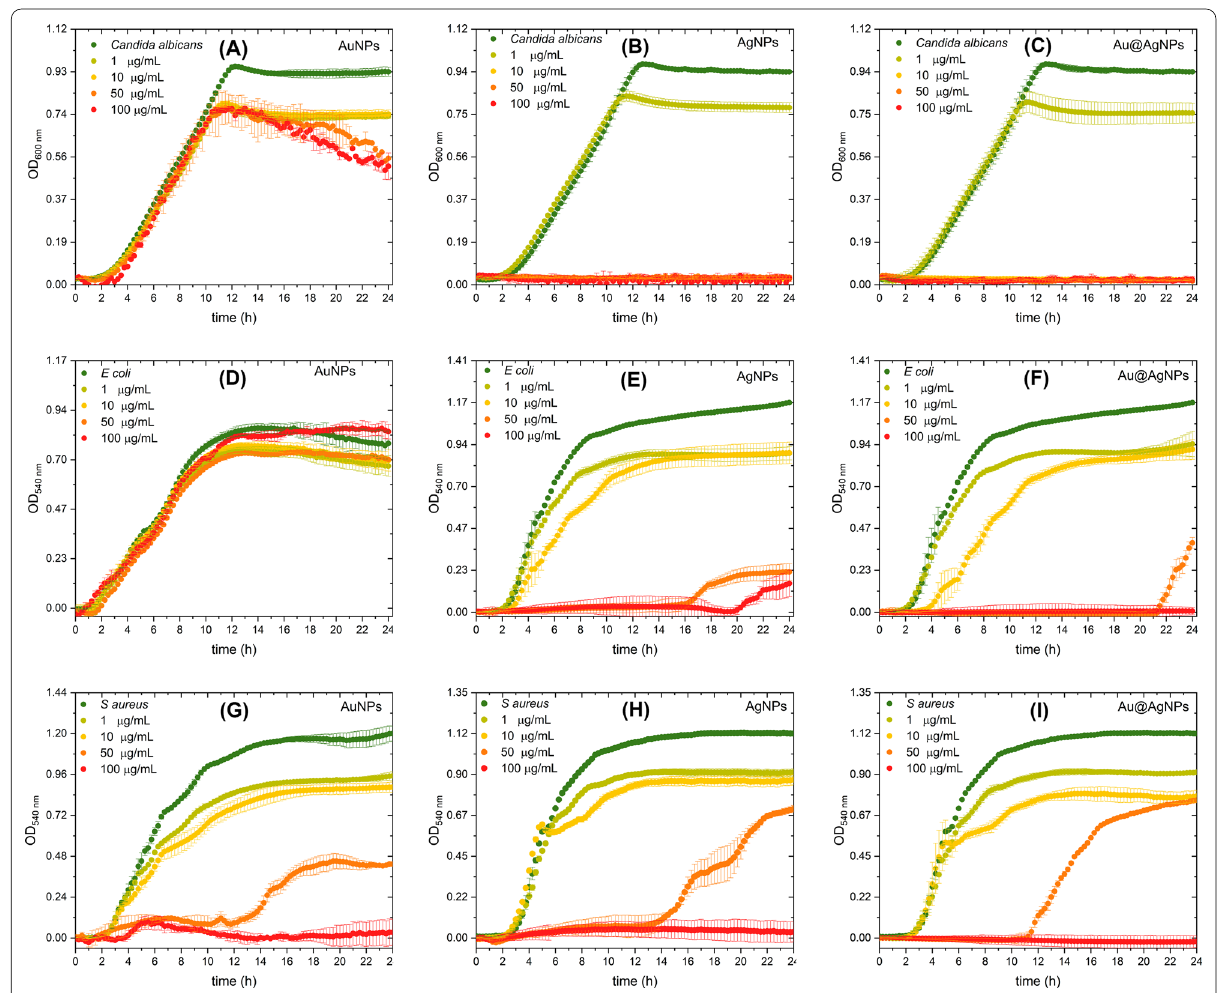
Fig. 9 The growth curves using AuNPs, AgNPs, and Au@AgNPs like inhibitory treatments on Candida albicans ( a – c ), Escherichia coli ( d – f ), and Staphylococcus aureus ( g – i